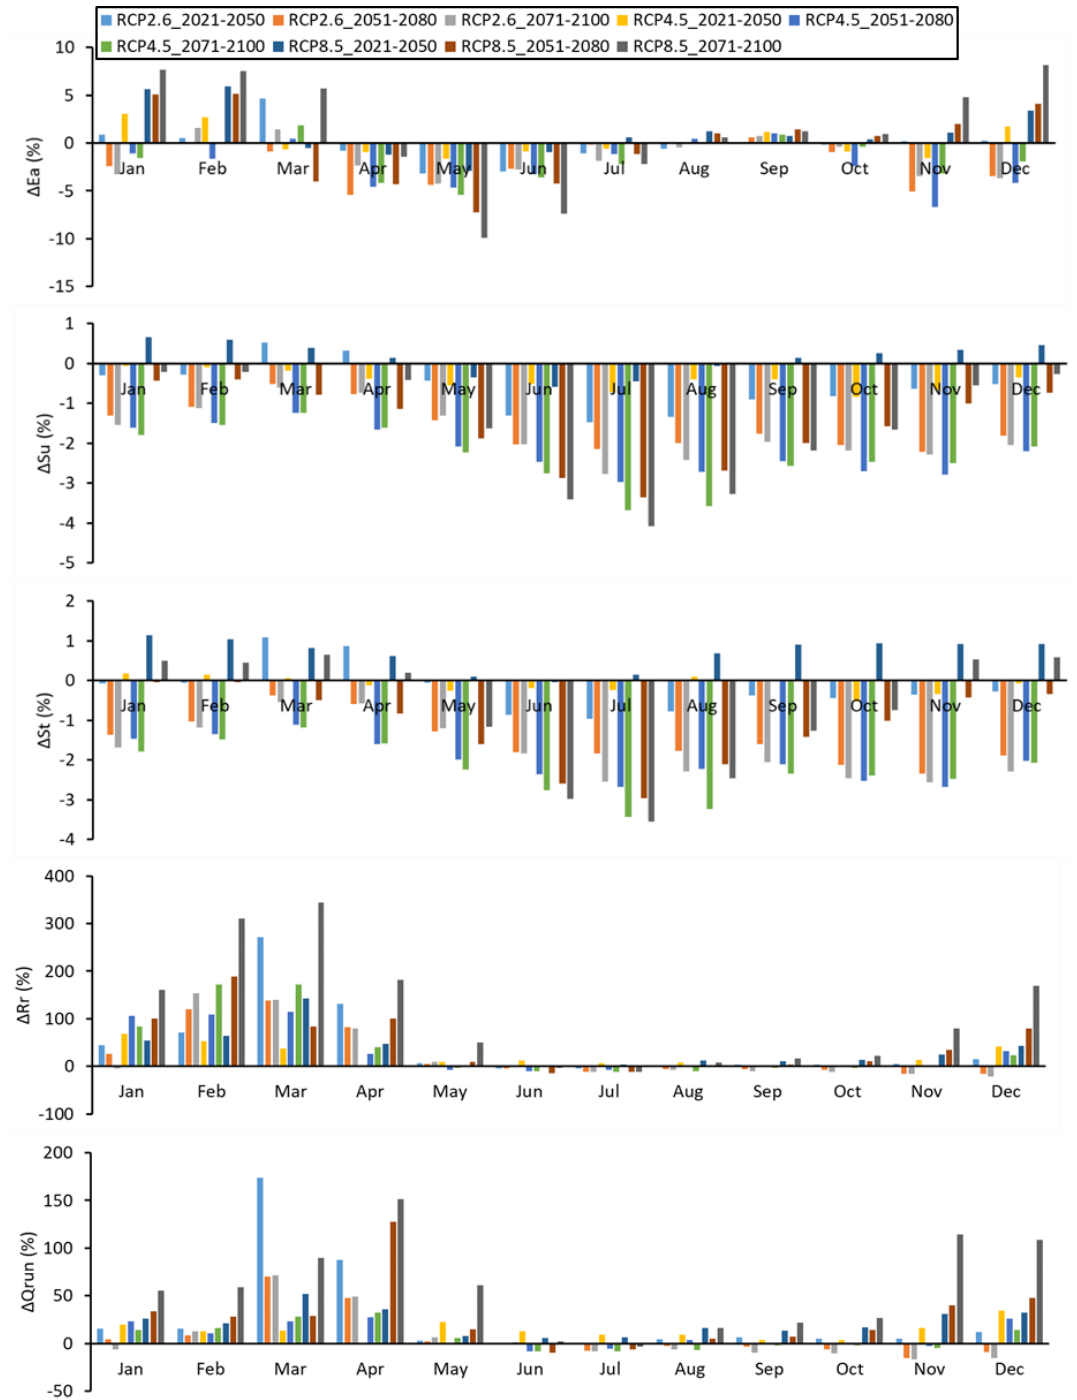
Figure 7. Mean seasonal changes (%) in hydrological variables ( E a , Q run , R r , S u , and S t ) over the future periods (2021–2050, 2051–2080, and 2071–2100) relative to the historical period (1991–2020).